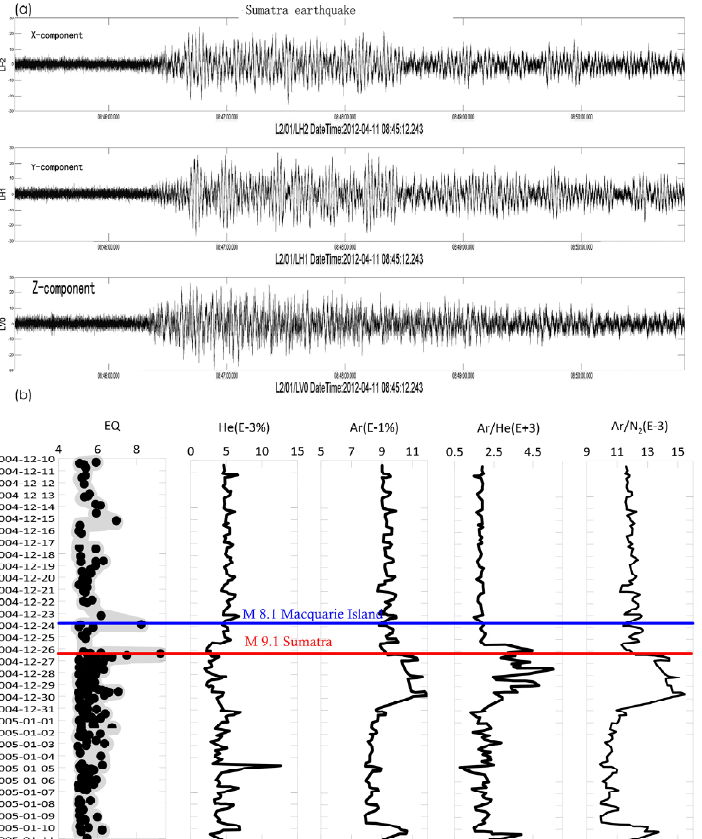
Figure 3. ( a ) A 3-component record of Sumatra earthquake observed. ( b ) Real-time gas anomalies observed during the CCSD drilling; the vertical ordinate is the date of observation; columns from the left to right are the seismic magnitude, records of helium, argon, argon/helium, and argon/nitrogen, respectively.